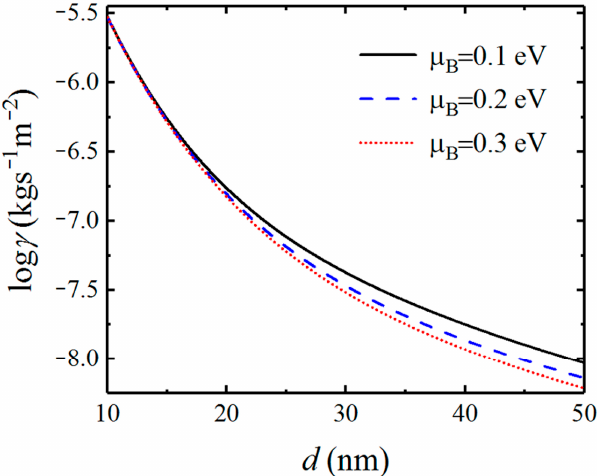
Figure 9. Dependence of the Casimir friction coefficient on the separation distances for different chemical potentials of Bi 2 Se 3 .